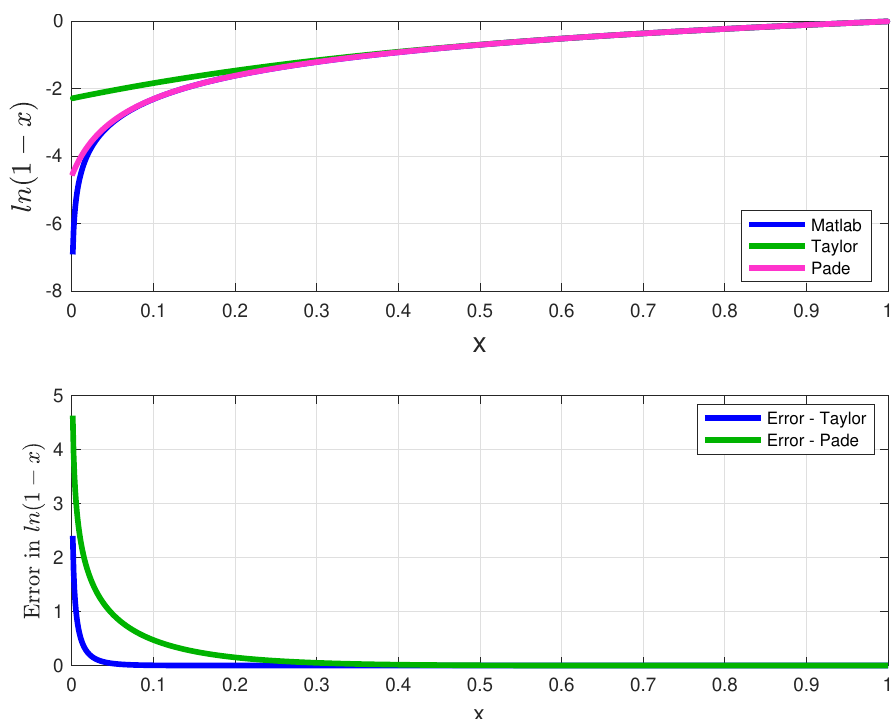
Figure 6. Approximate implementation of the natural logarithm. Figure 6 highlights the importance of numerical stability in the OCV–SOC